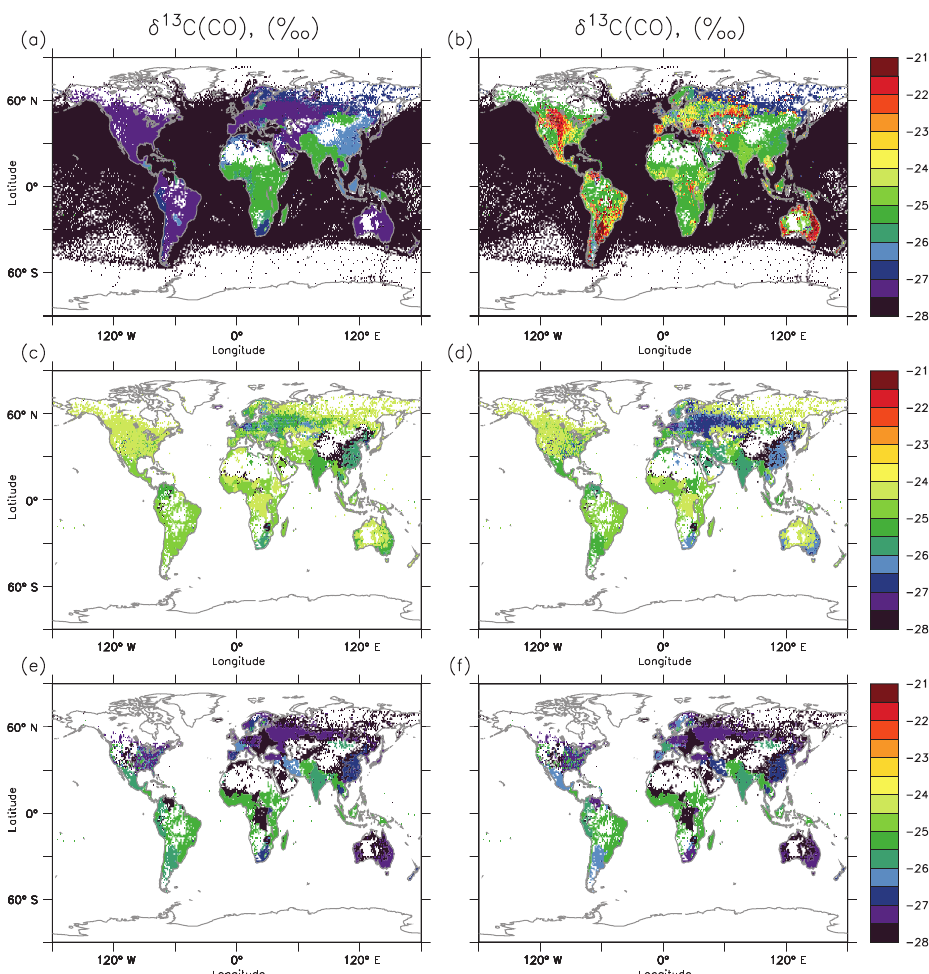
Figure 2. Stable carbon isotope composition of CO emitted from anthropogenic sources compiled on the basis of the EDGAR FT2000 inventory. Panels (a–f) refer to the specific emission heights of 45, 140, 240, 400, 600 and 800m (see text for